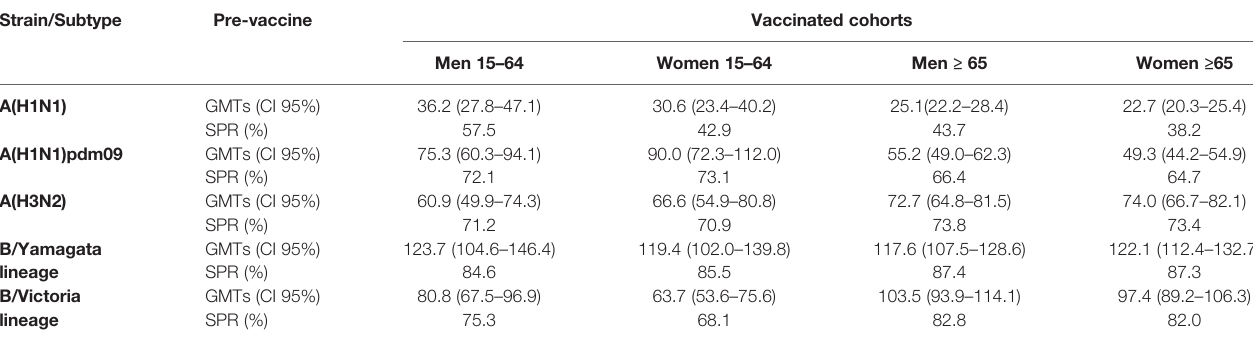
TABLE 2 | Humoral HI response to seasonal fl u vaccination by age and gender groups. Pre-vaccination values of the geometric mean titers (GMTs) and seroprotection rate (SPR).